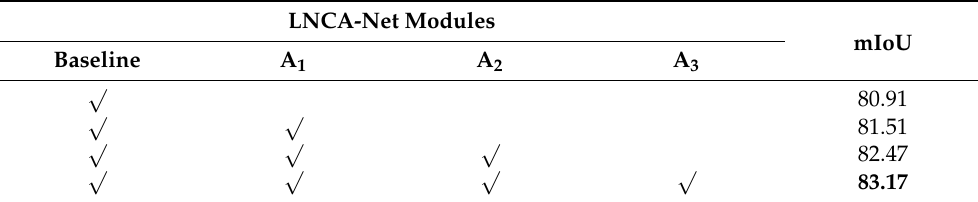
Table 4. Results of ablation experiments using the same dataset (BDCI 2017), where bold numbers indicate the highest mIoU and “√” indicates the top component used in the model. In each row, the last number represents the mIoU obtained using the corresponding component.